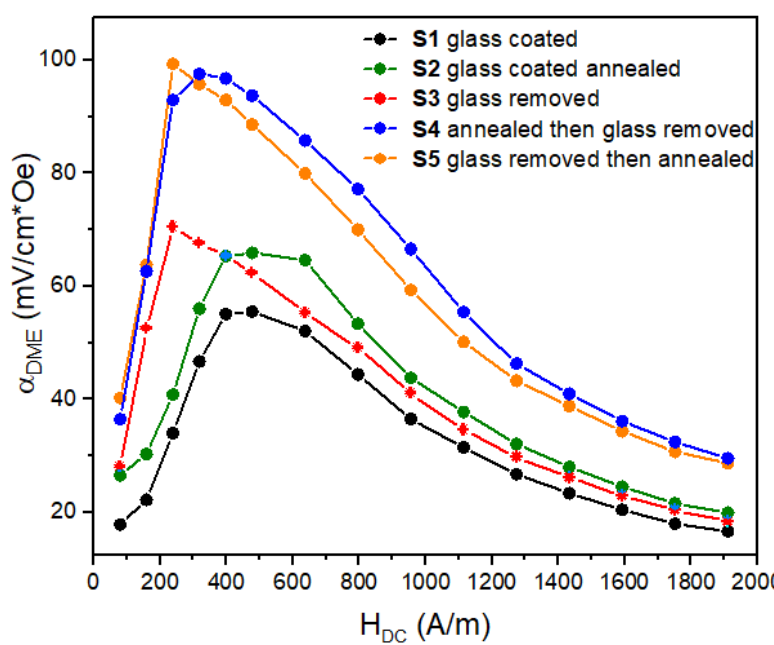
Figure 8. Dependencies of the ME voltage coe ffi cient α ME on DC magnetic field H DC field for S1-S5 composites at resonance condition.